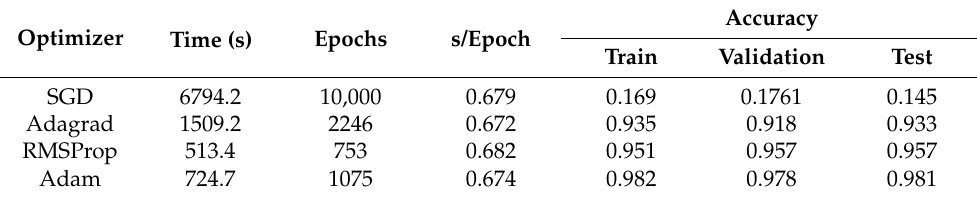
Table 2. Optimization speed and plant physiological disorder classification accuracy for the